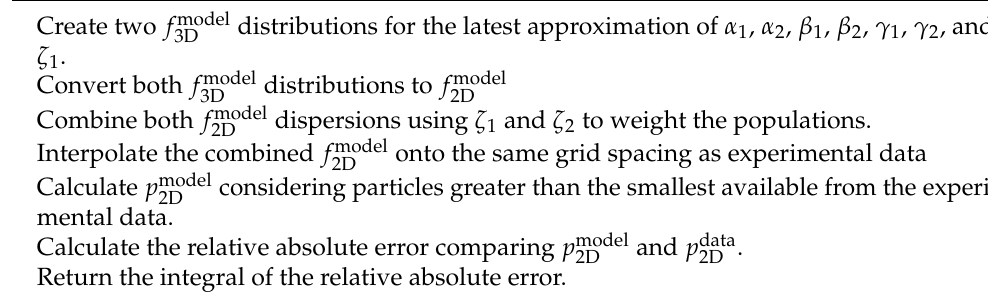
Algorithm 2 Simultaneous bimodal 3 D → 2 D approximation Create two f model